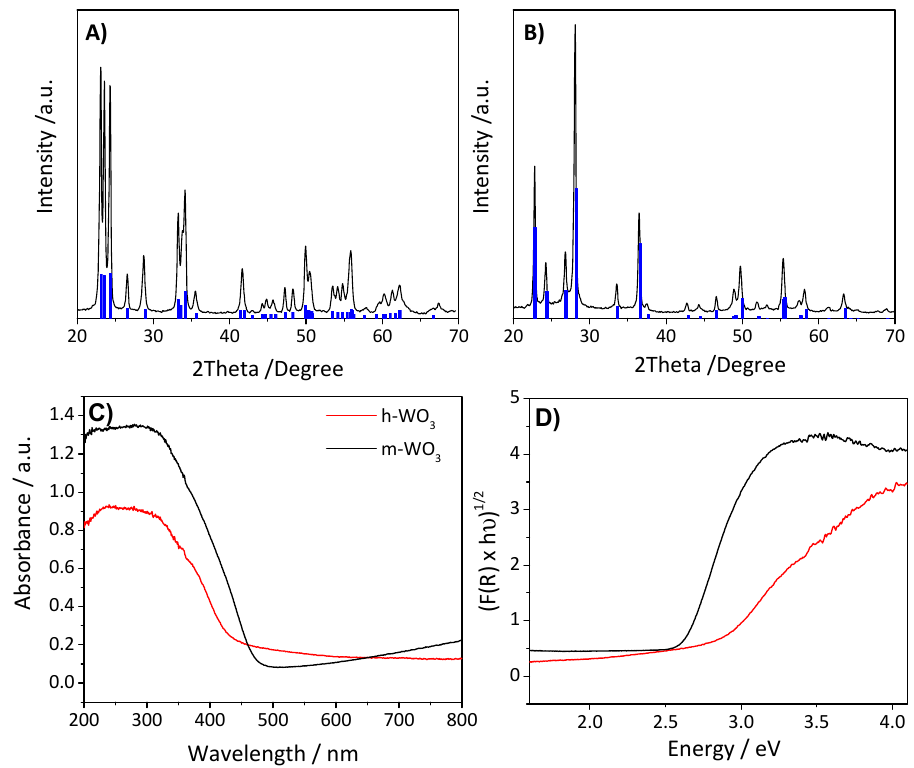
Figure 1. X-ray diffraction pattern of the ( A ) monoclinic and ( B ) hexagonal WO 3 . Blue bars indicate the standard patterns (JCPDS-01-075-2187 and JCPDS-01-083-0950 for the hexagonal and monoclinic lattice, respectively); ( C ) Absorbance spectra and ( D ) Tauc representation of hexagonal and monoclinic WO 3 .